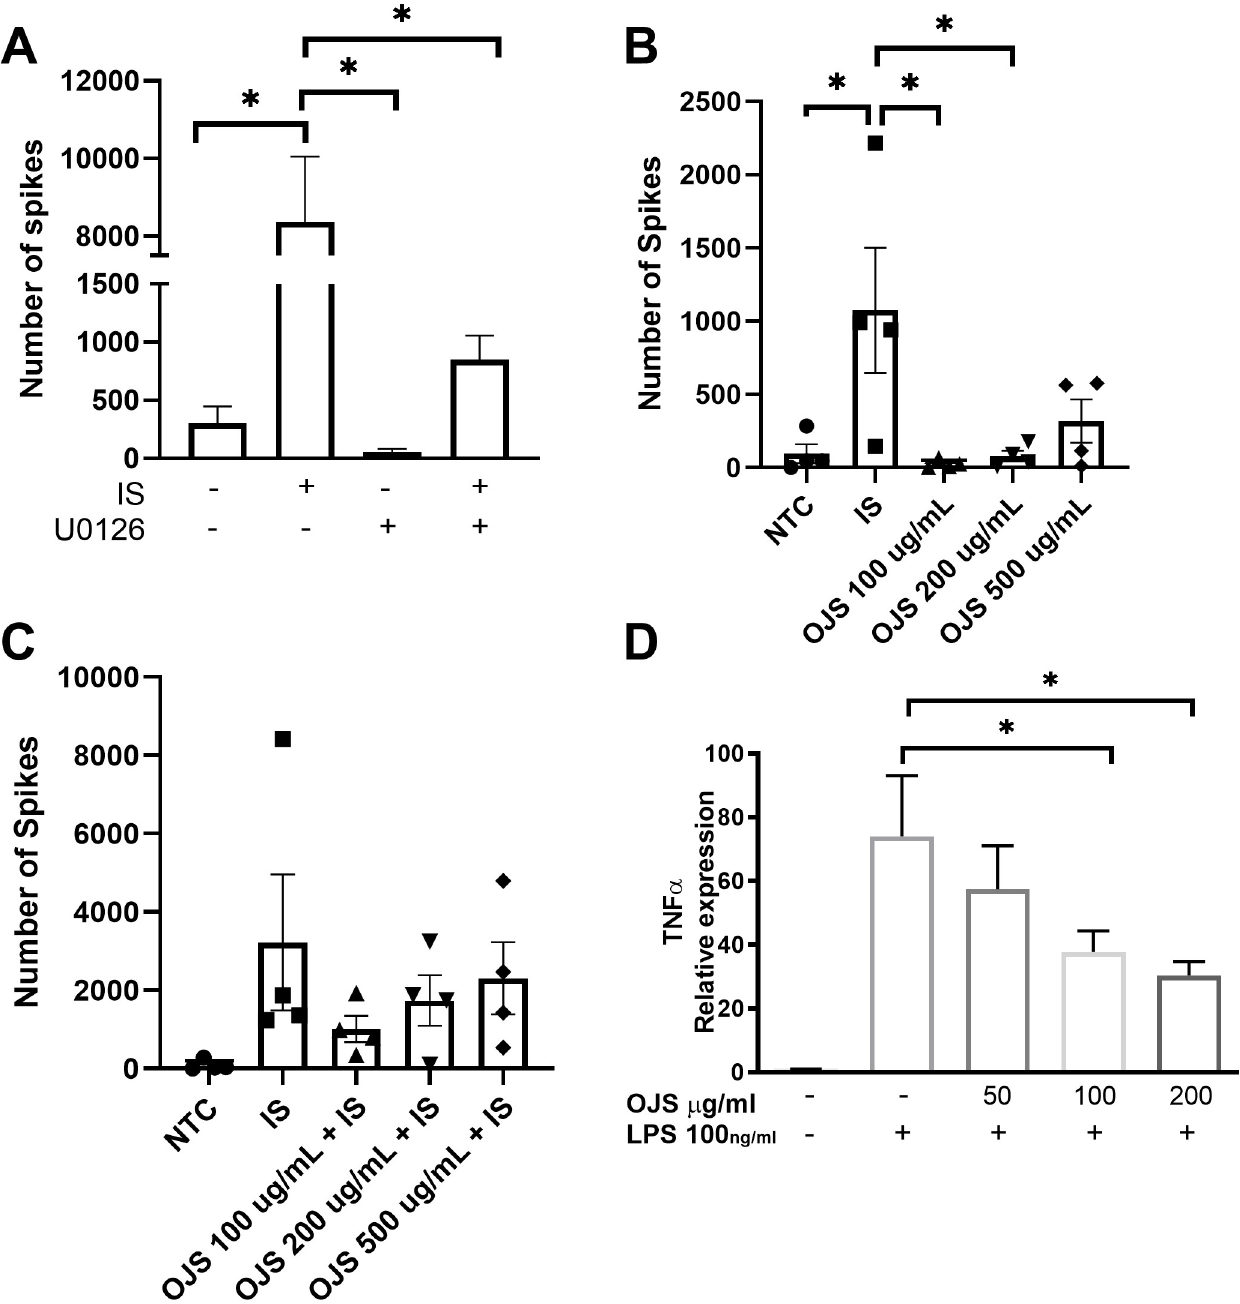
Fig 9. Pre-treatment of OJS did not mitigate DRG activation but decreased inflammatory responses in BMDM. (A) Rat DRG sensory afferents were given inflammatory mediators (IS, inflammatory soup) and U0126 (Erk inhibitor) to determine DRG excitability. (B) The impact of an OJS dose response (100, 200, and 500 μ g/mL) on spontaneous DRG firing. (C) Pre-treatment of OJS (100, 200, and 500 μ g/mL) 15 min prior to activating DRG afferents with IS. (D) TNF α mRNA expression resulting from LPS-stimulated BMDM. Each bar represents the mean + SE obtained from at least three biological replicates. � Indicates statistical significance between groups (p < 0.05) from one-way ANOVA Tukey’s post hoc, n = 3/4 per group.